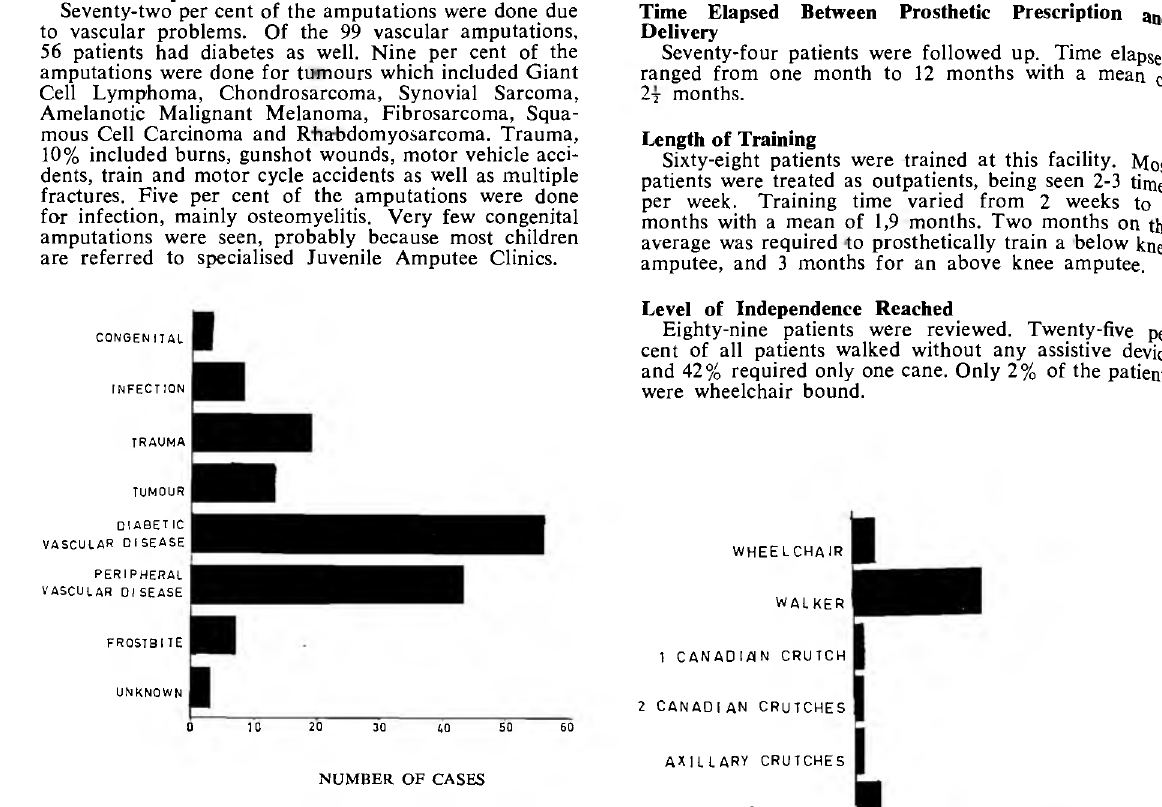
Figure 4. Cause of Amputation